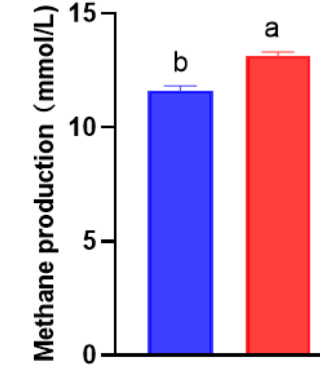
Figure 1. Total gas production ( left ) and methane production ( right ) at 12 h and 24 h incubation. R12, in vitro rumen fermentation at 12 h; R24, in vitro rumen fermentation at 24 h. a,b Different lower-case letters indicate significant differences between the R12 and R24.